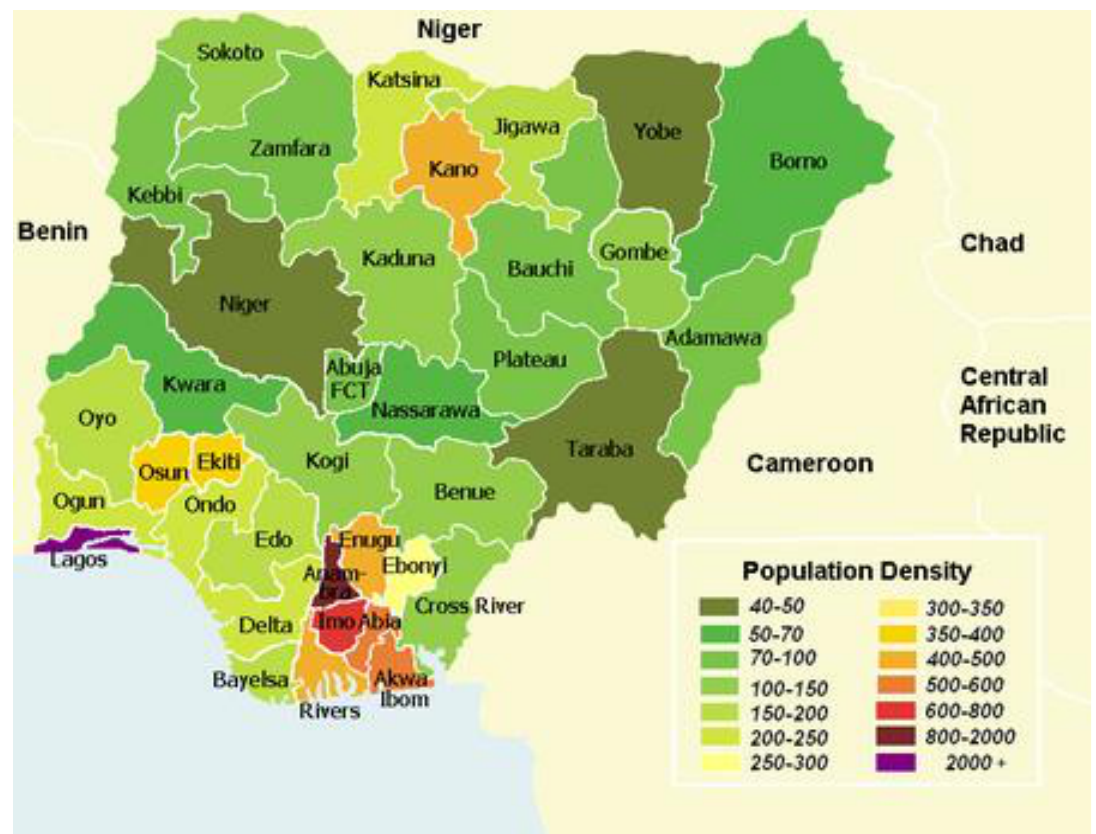
Figure 1. Map of